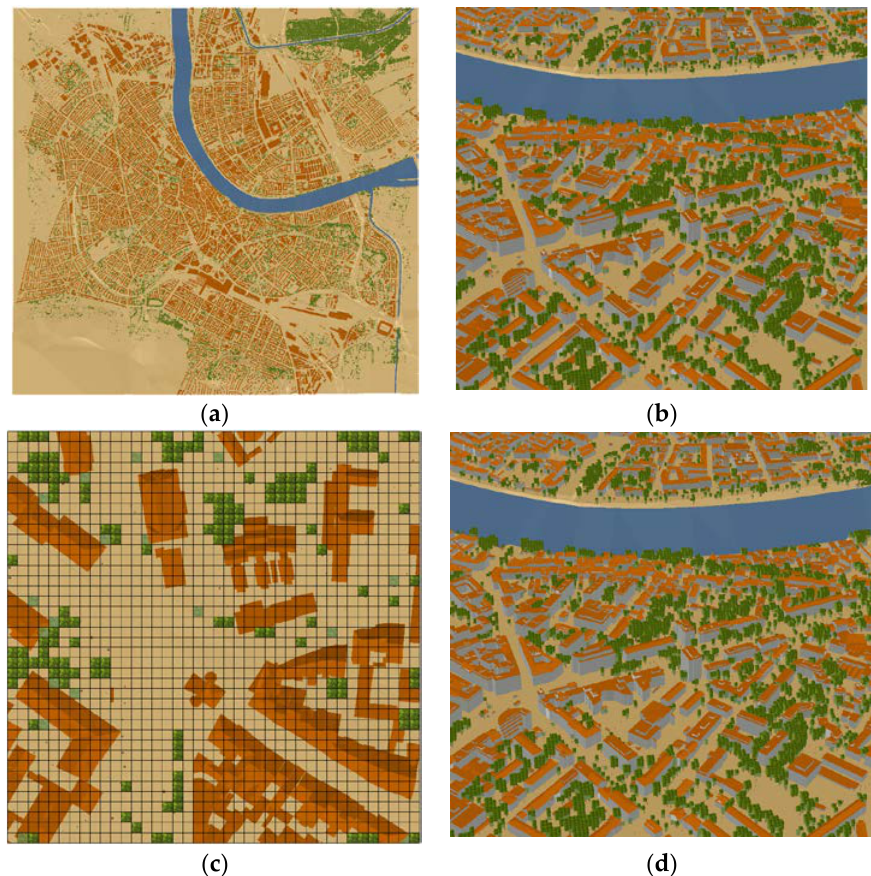
Figure 7. The BASEL scene: ( a ) Overview of the BASEL scene, ( b ) Three-dimensional (3D) view of a part of the scene, ( c ) Voxelization of the scene in 5 m resolution and ( d ) Voxelization of the scene in 10 m resolution.